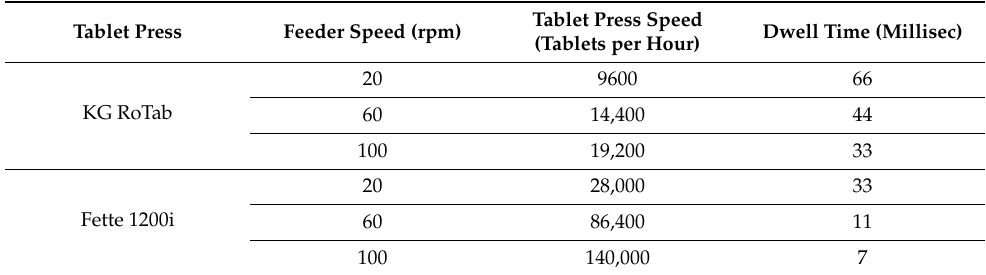
Table 2. DoE feeder speed and tablet press speed levels and associated dwell times for each tablet